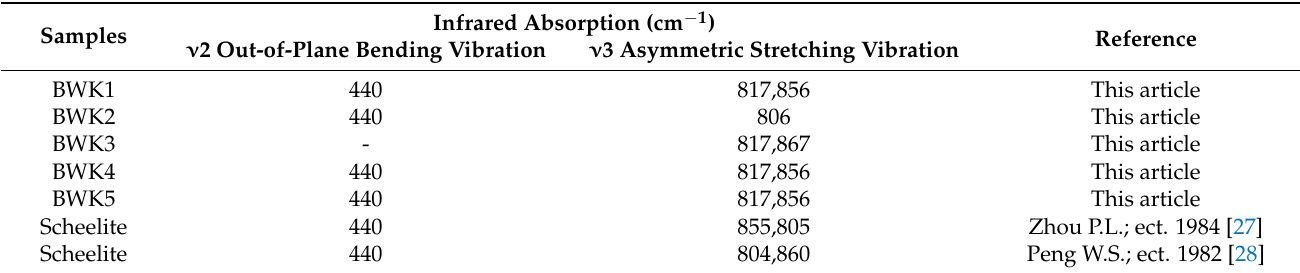
Table 1. Infrared reflectance absorption analysis of scheelite samples BWK1 − 5.